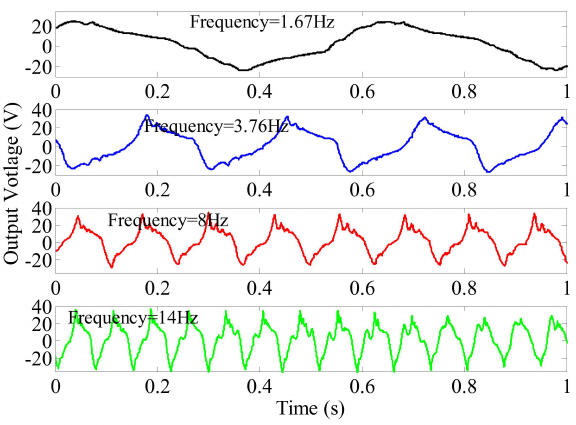
Figure 10. External voltages with resistors versus rotating frequency.